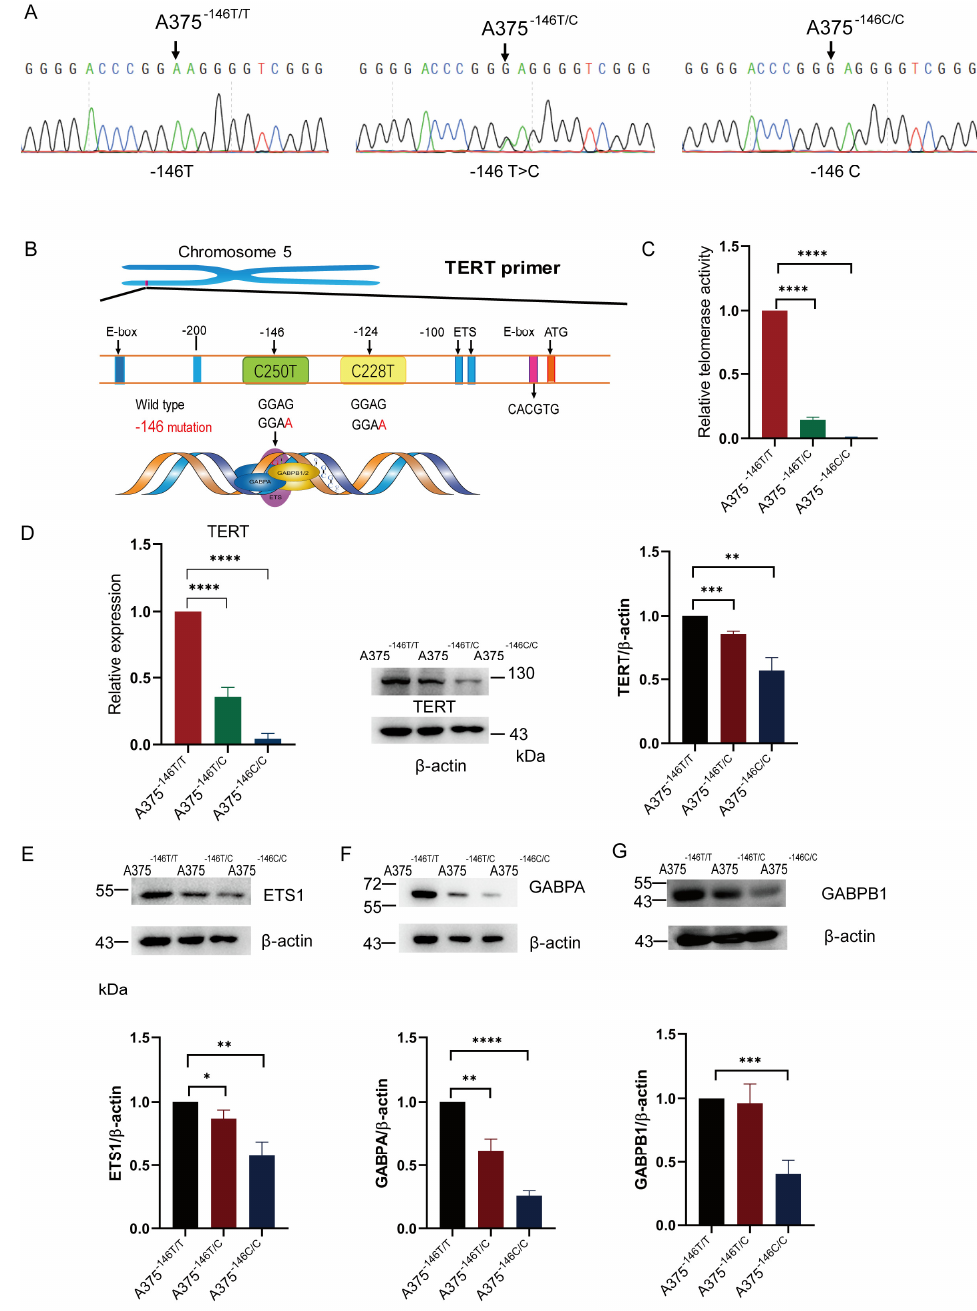
Figure 1. TERT -146 T>C inhibits TERT expression. ( A ) Sanger sequencing of A375 -146T/T , A375 -146T/C , and A375 -146C/C . Cells were transfected with a plasmid expressing sgRNA and SpCas9-NG. The DNA covering −146 C>T in the TERT promoter was analyzed by Sanger sequencing. The arrows (upper panel) indicate mutations (lower panel). A375 -146T/T , wildtype. A375 -146T/C , heterozygous cells. A375 -146C/C , homozygous cells; ( B ) schematic diagram of telomerase activation; ( C ) telomerase activity as- say. Determination of telomerase activity by using the Real-time Q-TRAP; ( D ) TERT transcription and expression in A375 -146T/T and cells with TERT promoter revertant mutations; ( E ) Western blot and gray value analyses of ETS1 protein expression in A375 -146T/T , A375 -146T/C , and A375 -146C/C ; ( F ) Western blot and gray value analyses of GABPA protein expression in A375 -146T/T , A375 -146T/C , and